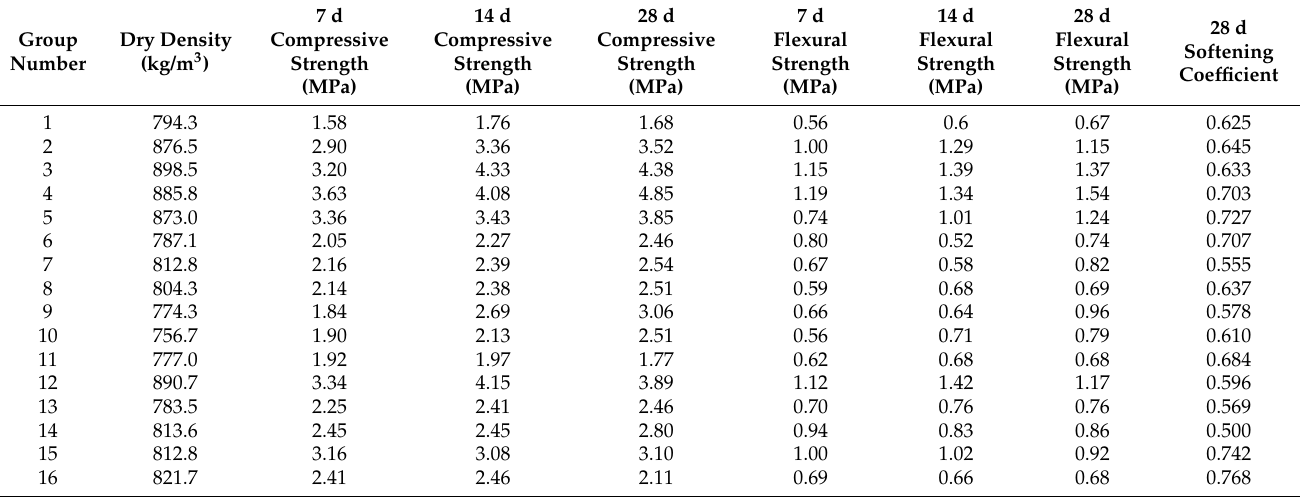
Table 4. Table 4. Orthogonal experimental results.